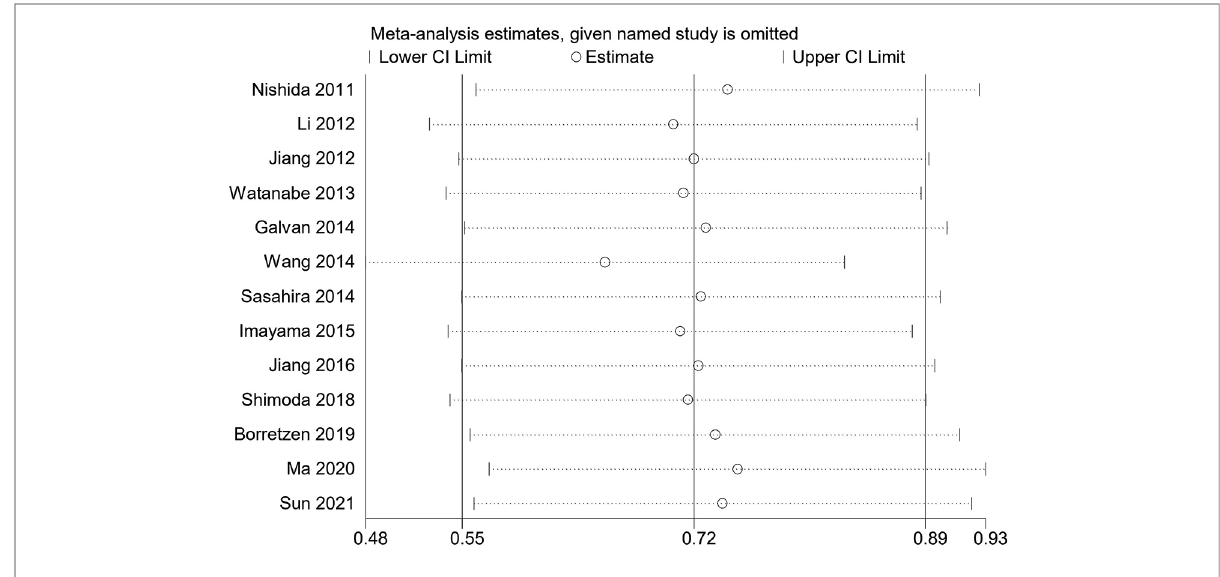
FIGURE 4 Sensitivity analysis regarding overall survival.